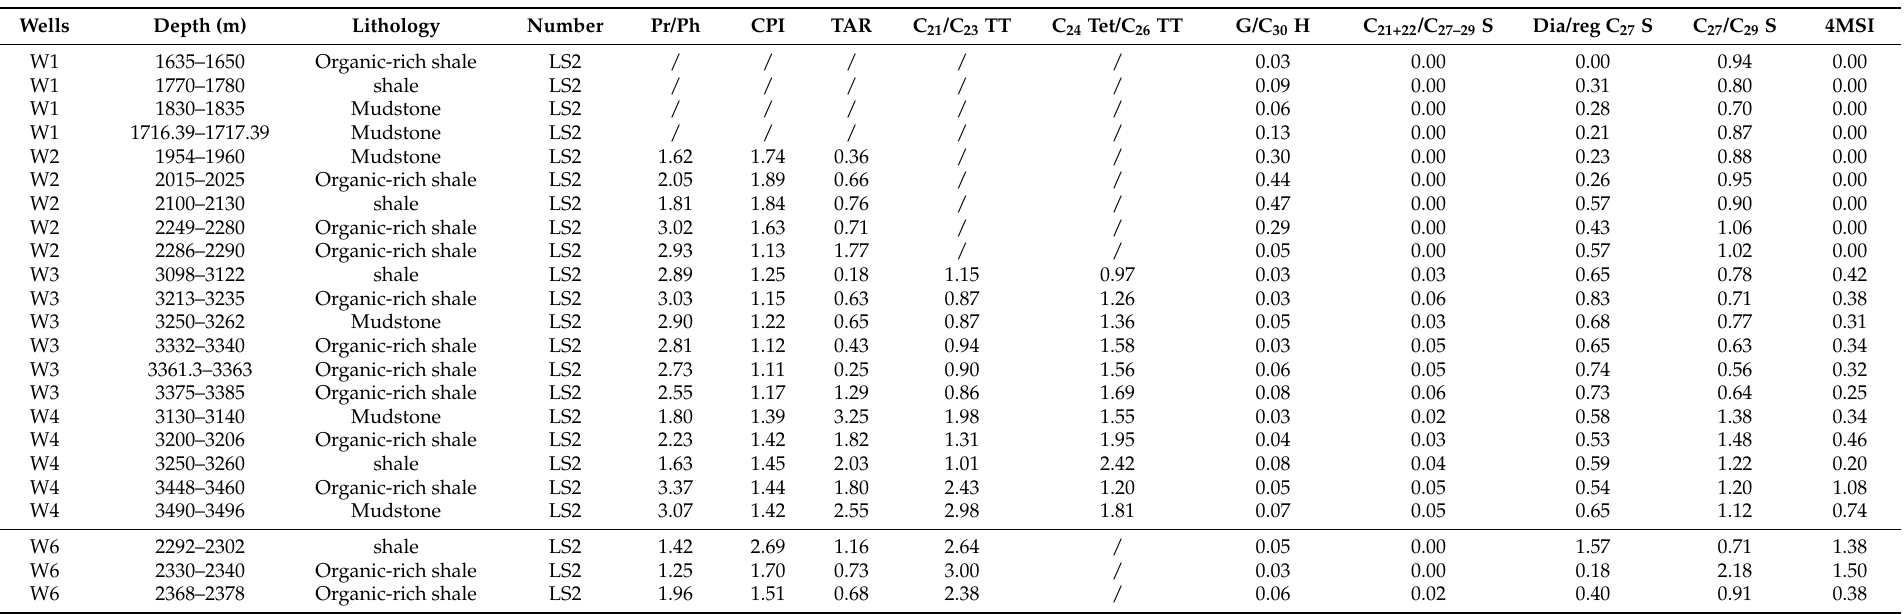
Table 2. Selected molecular parameters for source rock samples from LS2 of the Weixinan Sag, Beibuwan